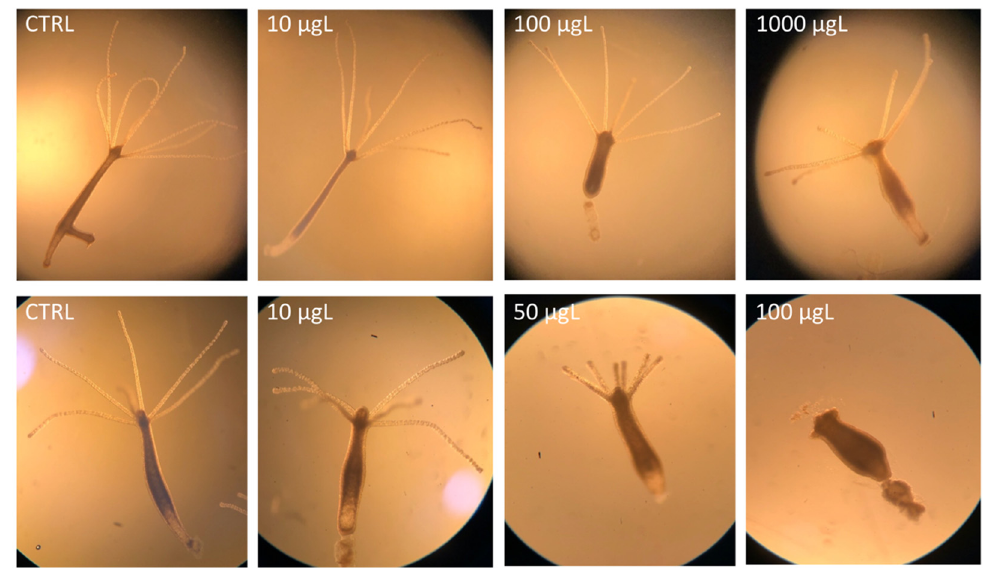
Figure 1. Morphology of H. vulgaris exposed to AgNPcitLcys ( upper row ) and AgNO 3 ( lower row ) for 96 h at 0 (CTRL), 10, 100, and 1000 μ g/L and 0 (CTRL), 10, 50, and 100 μ g/L, respectively.